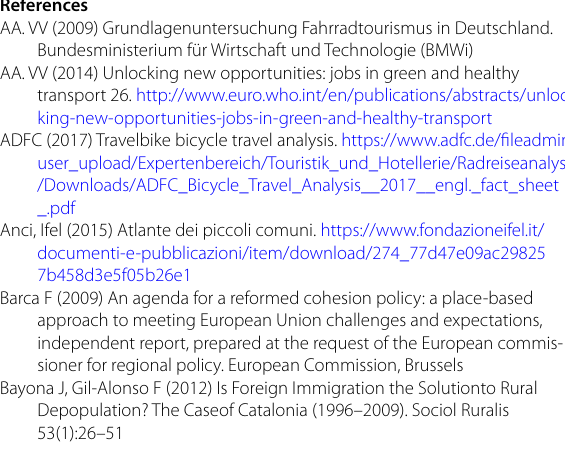
the smaller and more isolated these municipalities are, the more they have to be able to interact beyond administrative fragmentation.